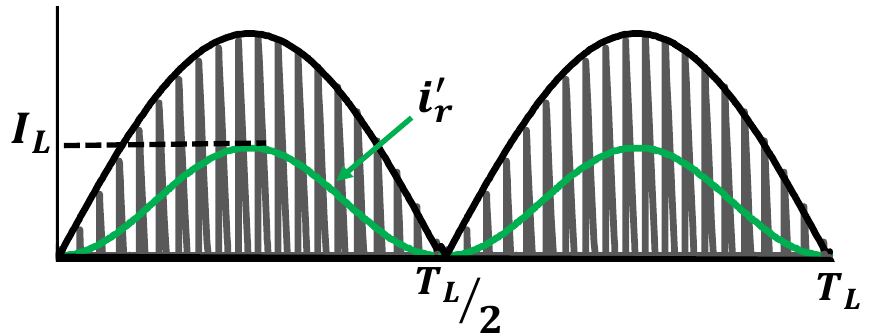
(17) Figure 12. Instantaneous current delivered by the rectifier seen at a high frequency. From Equation (17), it is possible to obtain the average high-frequency current deliv- ered by the rectifier, which is defined as (18) The instantaneous current delivered by the rectifier at a low frequency is defined as '